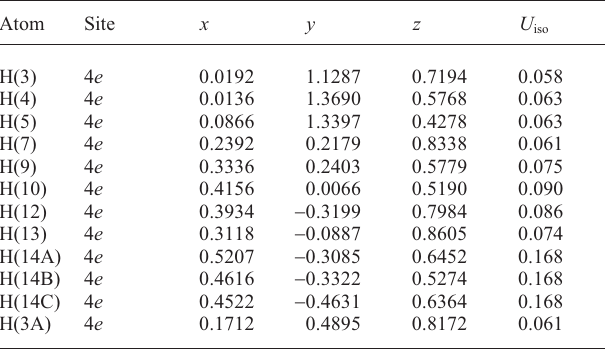
non-hydrogen atoms of the title compound are almost planar with the maximum deviation is 0.1080(7) Å for C5. The C6–N3, N3–N4, and C7–N4 bond lengths are 1.343(3) Å, 1.366(3) Å, and 1.280(3) Å, respectively. The C1–S1 and C6–S1 bond lengths of 1.744(3) Å and 1.750(3) Å are intermediate between the double and single bonds. The crystal packing of the title compound ex- hibits intermolecule N–H (cid:2)(cid:2)(cid:2) N hydrogen bonds. Adjacent mole- cules are linked by the N3–H3A (cid:2)(cid:2)(cid:2) N1 i hydrogen bonds into one- dimensional chain. The distance of H3A (cid:2)(cid:2)(cid:2) N1 is 2.02 Å, the dis- tance of N3 (cid:2)(cid:2)(cid:2) N1 is 2.881(3) Å, and the angle of N3–H3A (cid:2)(cid:2)(cid:2) N1 is , z + 1 . Table 1. Data collection and handling. 178.6°. Symmetry code i: x , – y + 3 2 2 Table 2. Atomic coordinates and displacement parameters (in Å 2 )